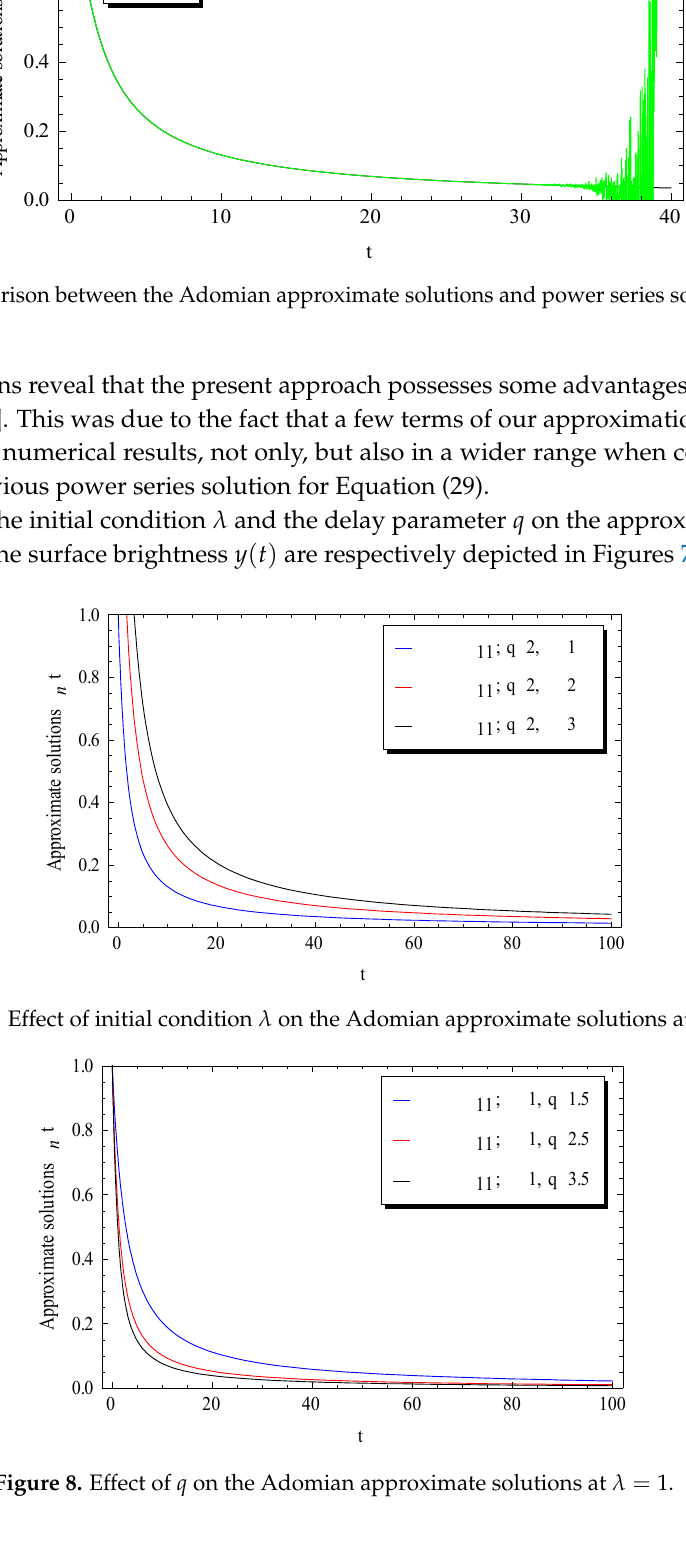
Figure 8. Effect of q on the Adomian approximate solutions at 1 =λ .